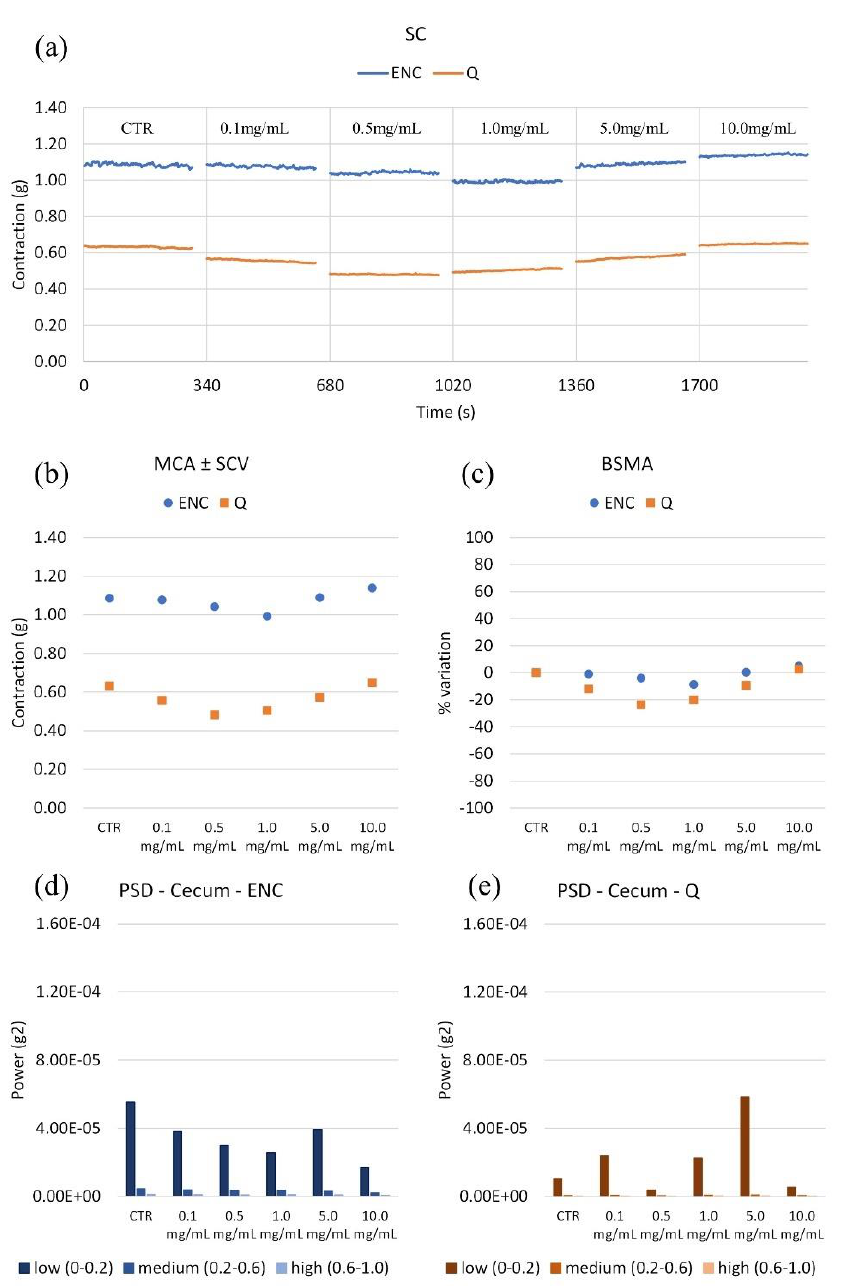
Figure 4. ( a ) Experimental original recording of the concentration–response curve of ENC ( Castanea sativa Mill.) and Q ( Schinopsis balansae Engl.) extract on caecum spontaneous